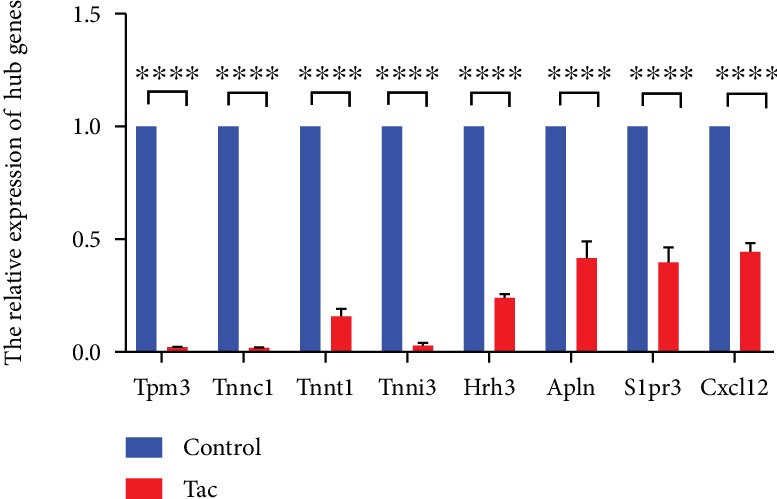
The relative expression of hub genes. Data are means ± SD. ∗∗∗∗p < 0.0001.